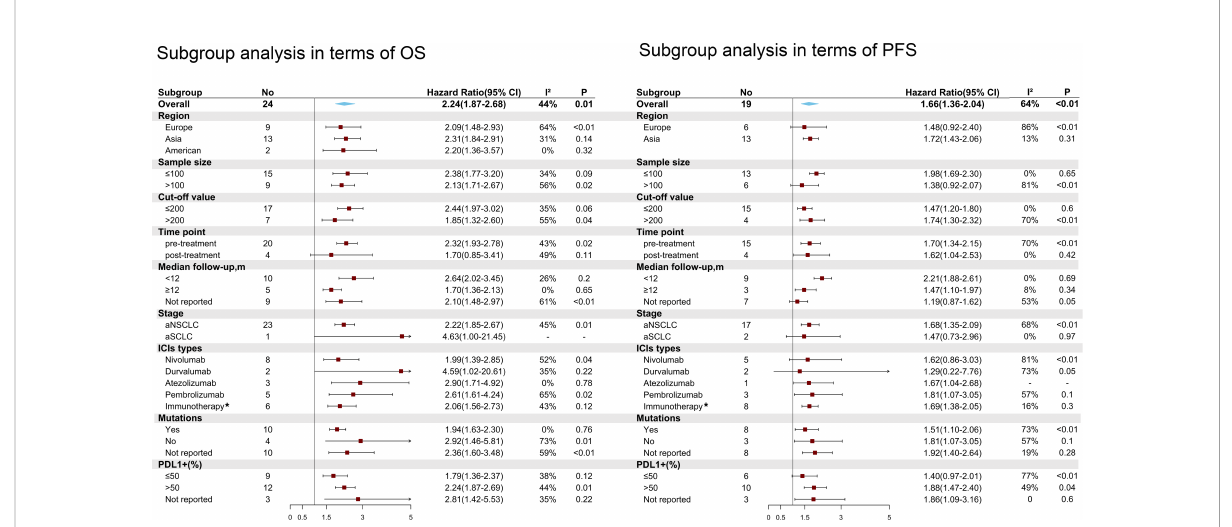
FIGURE 5 Subgroup analyses of the associations between the platelet to lymphocyte ratio (PLR) and overall survival (OS) and progression-free survival (PFS). *Immunotherapy means these articles reporting different types of ICIs or no detailed types of